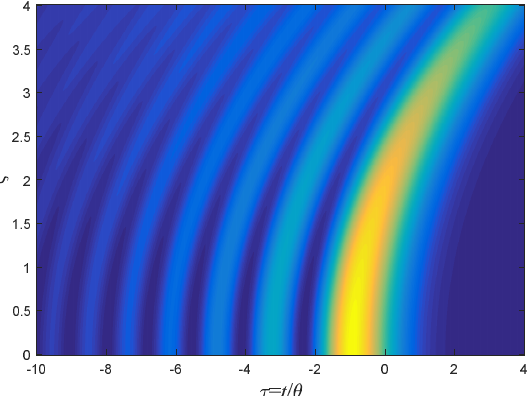
2 ) of the pulse presented by Equation (92).   2 , ztA ) of the pulse presented by Equation (92). Figure 27. Same as Figure 2, but for the intensity ( | A ( t , z ) |